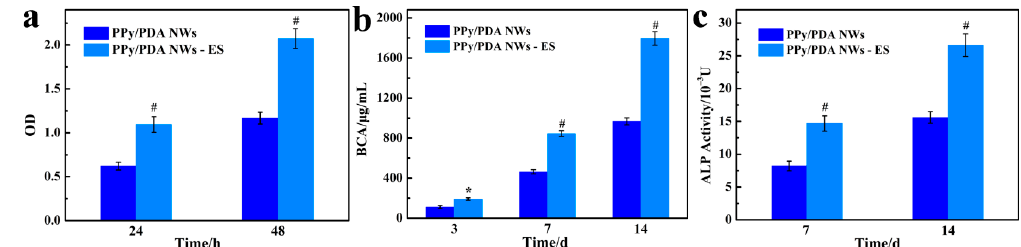
Figure 6. ( a ) The effect of ES on the proliferation of MC3T3-E1 cells on PPy/PDA NWs coating. ( b ) The effect of ES on the total protein content of MC3T3-E1 cells cultured on PPy/PDA NWs coating. ( c ) The effect of ES on the ALP activity of MC3T3-E1 cells cultured on PPy/PDA NWs coating. * p < 0.05, and # p < 0.01.